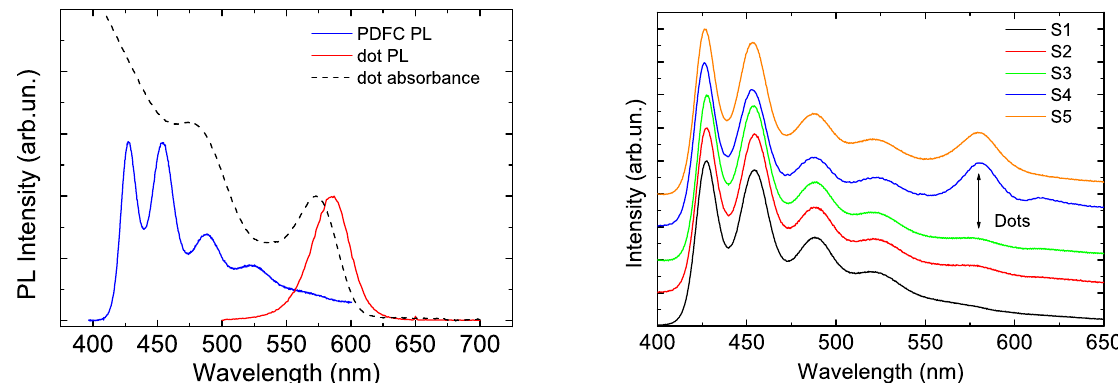
Figure 2. ( left ) Photoluminescence and absorption spectra of the CdSe/ZnS quantum dot, and PL spectrum of poly[(9,9-dihexylfluorenyl-2,7-diyl)-alt-co-(9,ethyl-3,6-carbazole)] (PDFC). ( right ) PL spectra of the PDFC: CdSe/ZnS blends for increasing nanocrystal (NC) content from bottom to top. The arrow indicates the dots emission. Adapted with the permission from [35]. AIP Publishing, 2004.